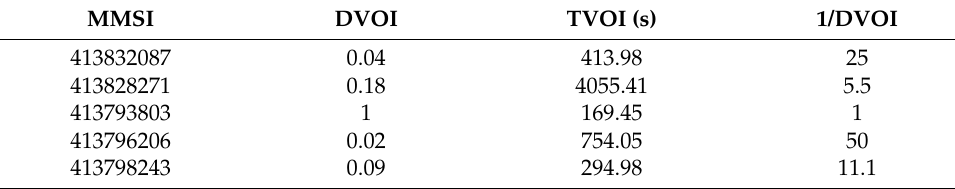
Figure 18. Pareto ranking of ship risk indicators in Case 4.